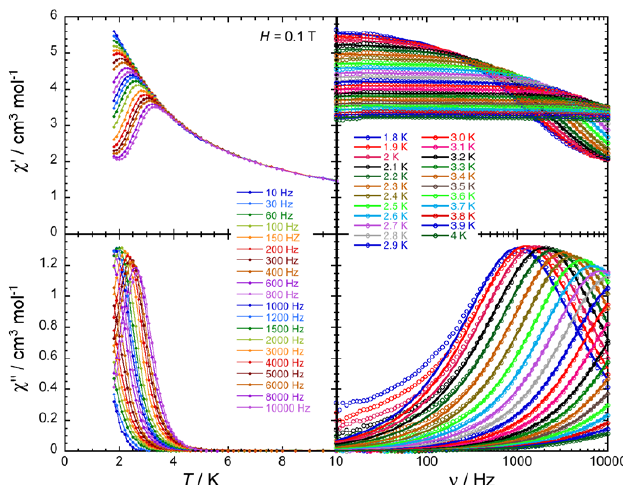
Figure 8. Frequency dependence of the real, in-phase ( χ ′, top) and imaginary, out-of-phase ( χ ", bottom) components of the ac susceptibility under an external dc field of 600 Oe (0.06 T) at the indicated temperatures for complex 3 ∙2.5MeOH. Solid lines are visual guides on the left plots, while they show the generalized Debye fit of the ac data on the right.